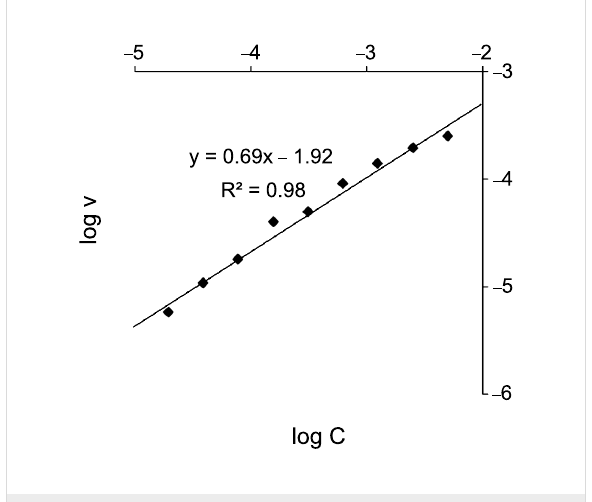
Figure 2: Reaction order for copper from 0.025–0.64 mol